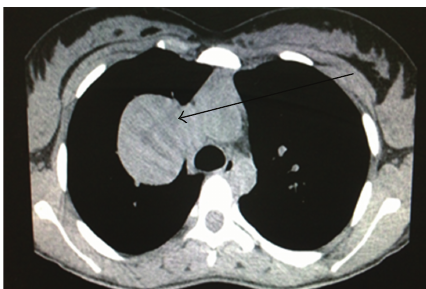
Figure 2: CT scan showing hypodensity (arrow) at the right upper lobe with significant compression to the superior venacava.